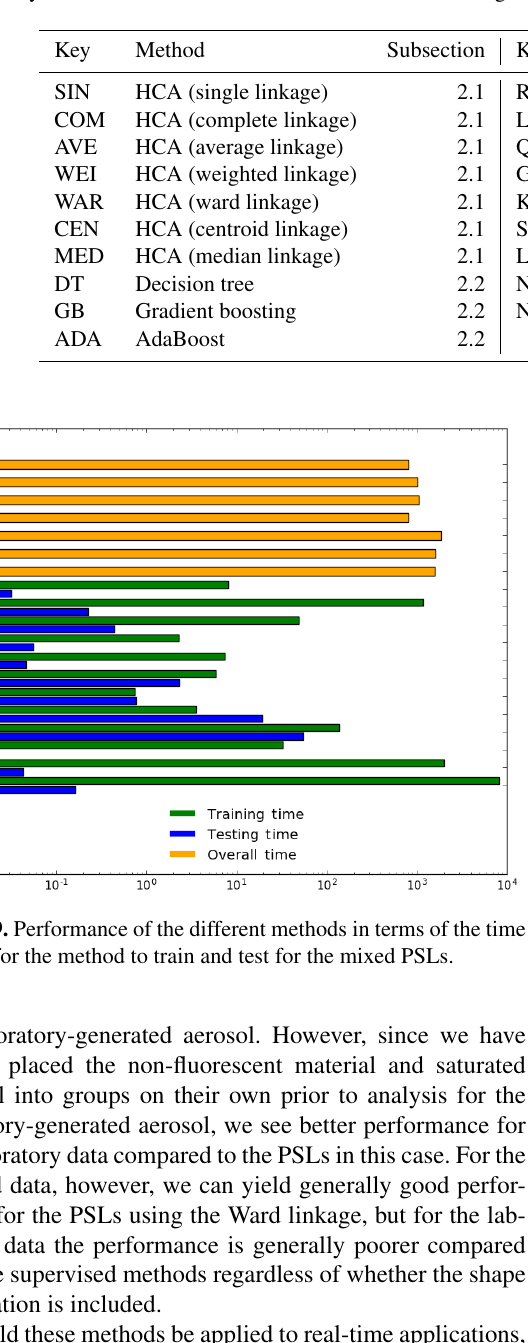
Table 3. Key for the shortened names for the different methods given in the figures.